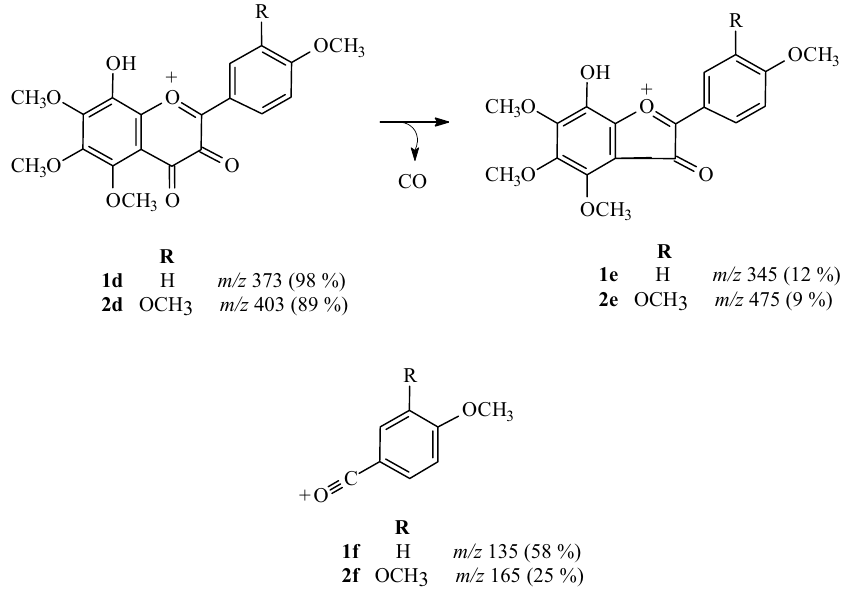
Fig. 2 – Ionic fragments attributed to principal peaks observed in the mass spectra of the 8- hydroxyflavonols 1 and 2